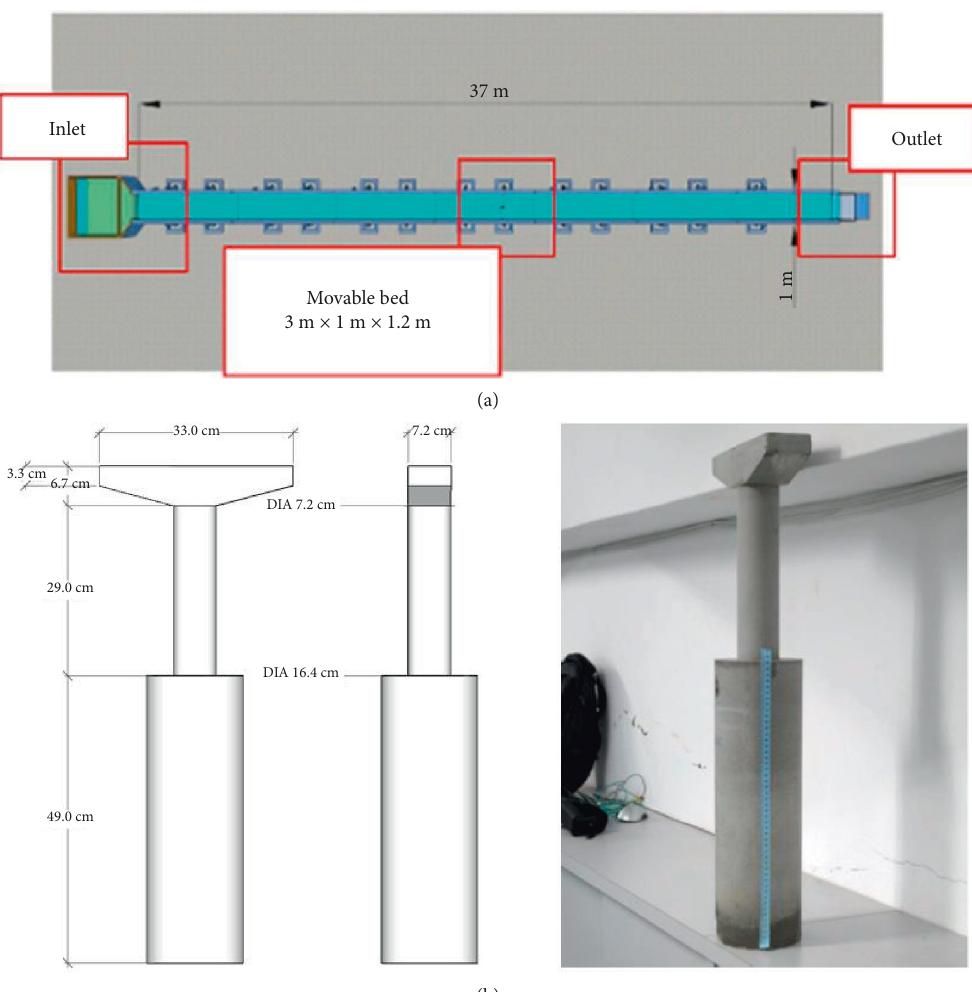
Figure 4: Scour experiment setup. (a) Sink facility. (b) Concrete pier